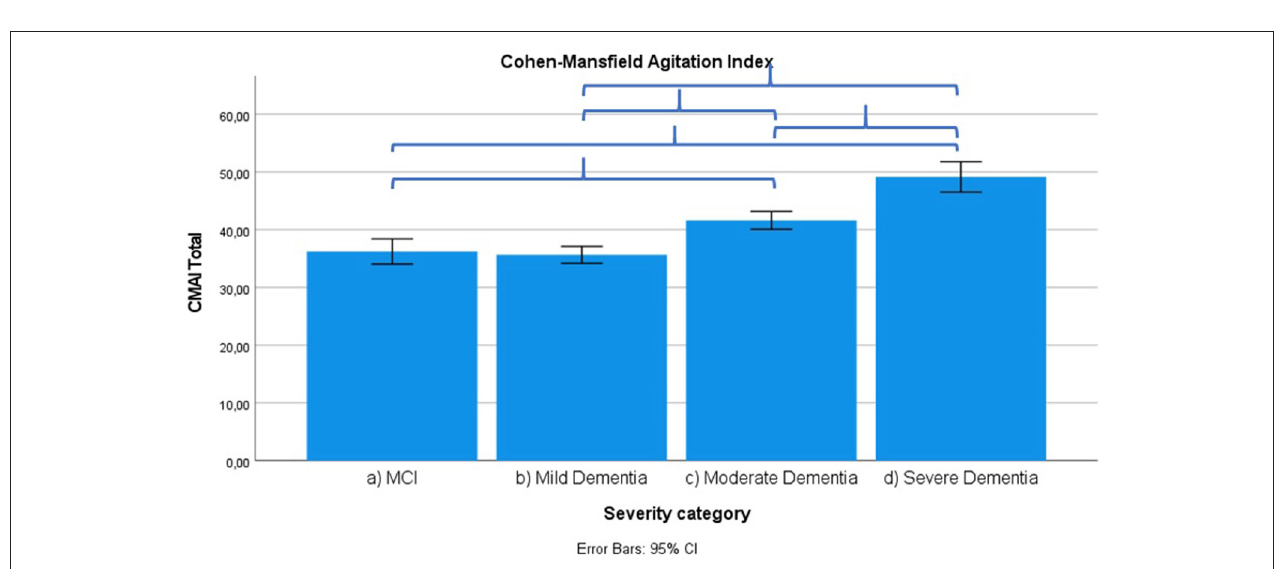
FIGURE 4 | Mean score on the Behave-AD scale total score according to severity of cognitive impairment. Error bars are 95% confidence interval. Curly brackets indicate p < 0.001.